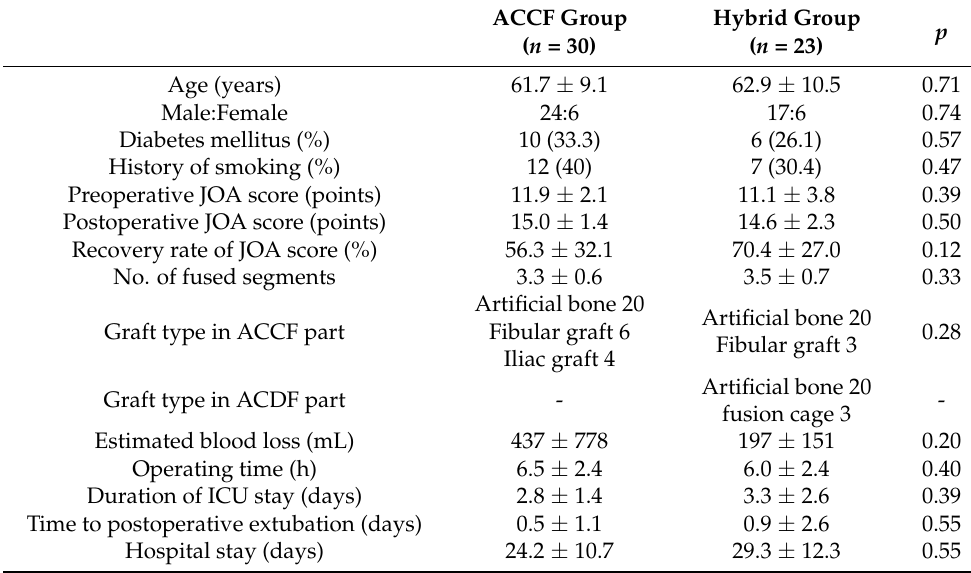
Table 2. Demographic and clinical characteristics in the ACCF and hybrid groups.